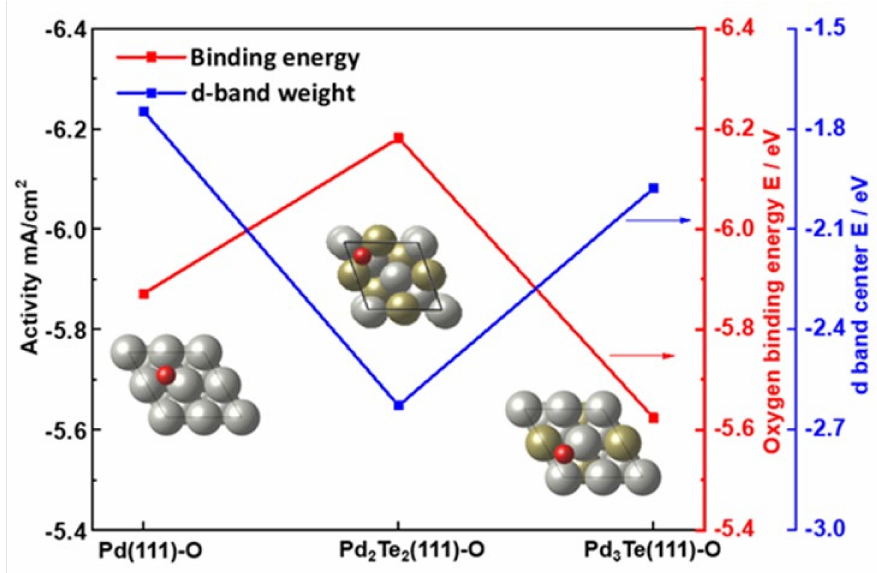
Figure 8. Theoretically specific activity recorded for ethanol oxidation and the oxygen binding energies and d-band center values recorded for the cases of Pd (111), Pd 2 Te 2 (111), and Pd 3 Te